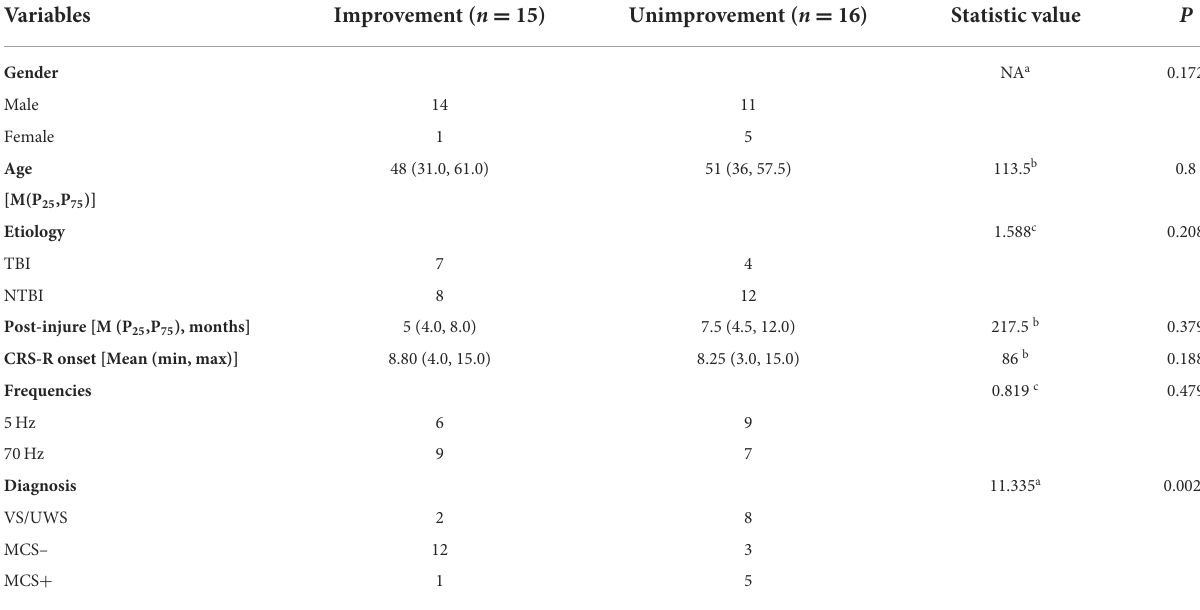
TABLE 3 Clinical variables comparisons between improvement and unimprovement.